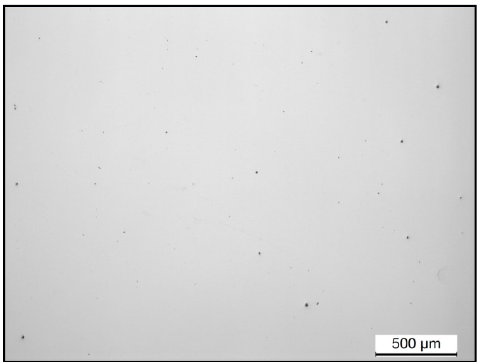
Figure 5. IN738LC sample manufactured with predicted optimum process parameters.